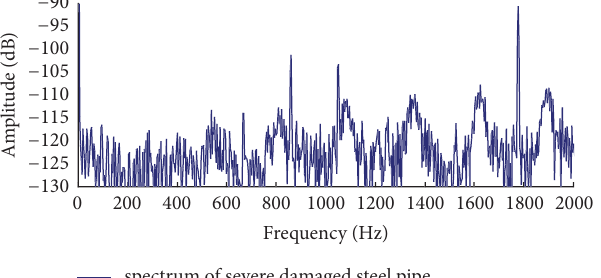
Figure 14: Spectral lines of the damaged pipe.